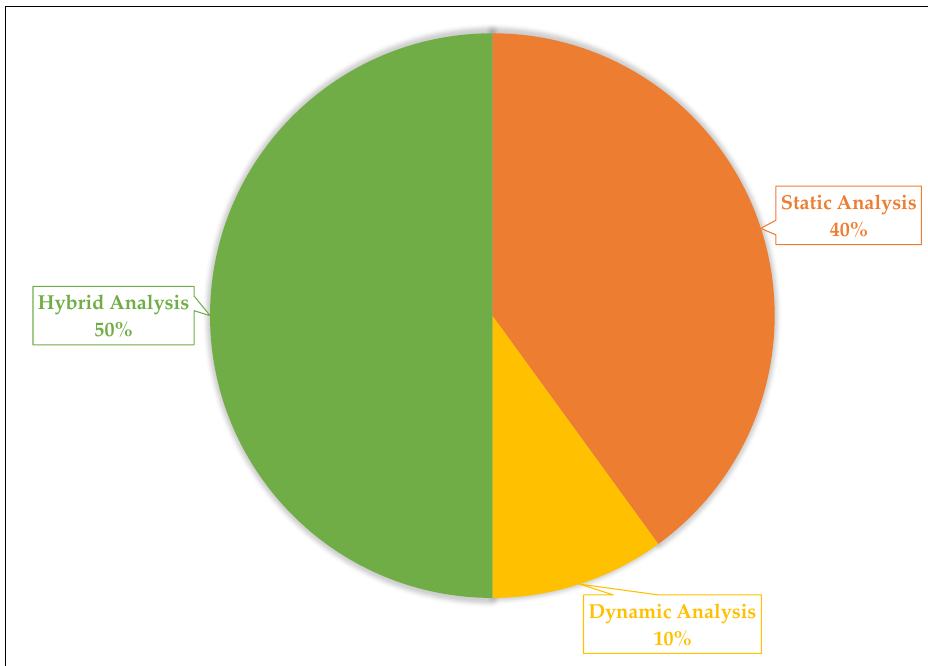
Figure 8. Android source code vulnerability analysis